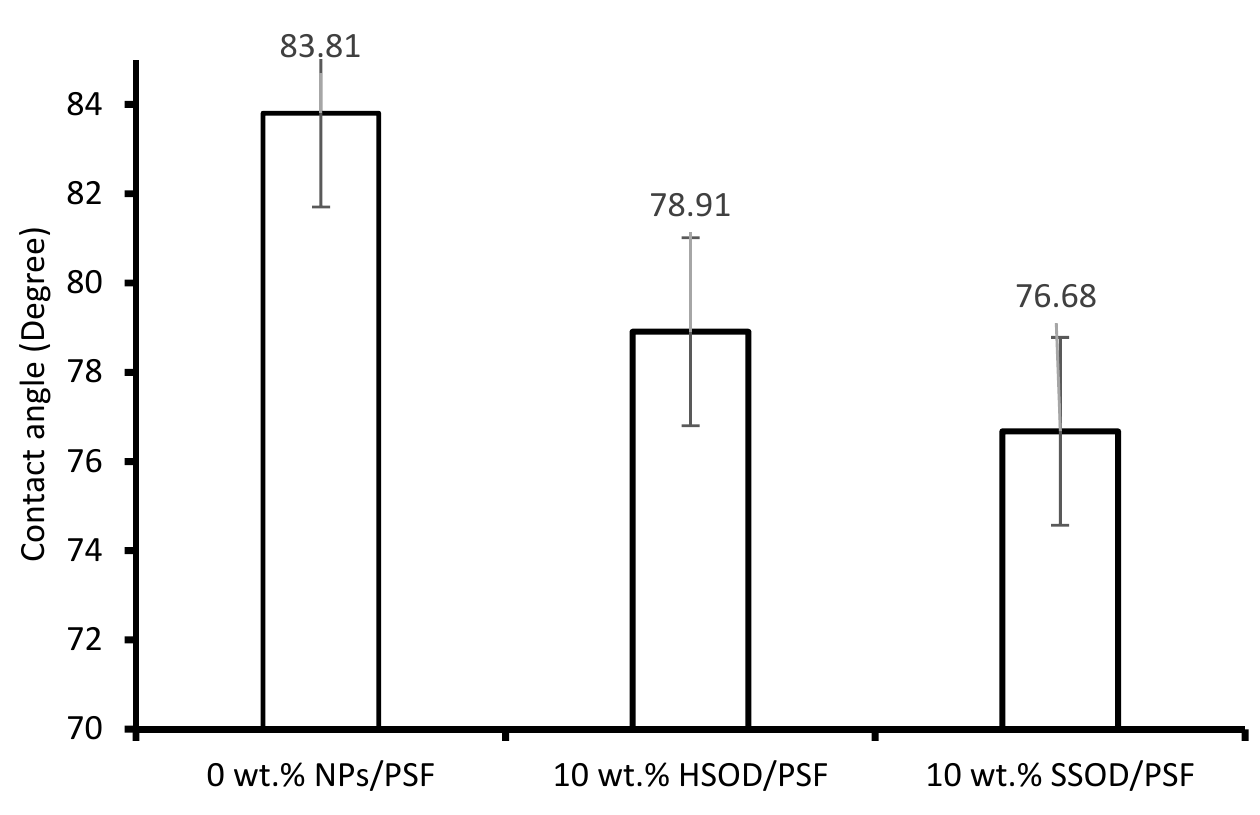
Figure 7. Contact angle of the fabricated membranes.